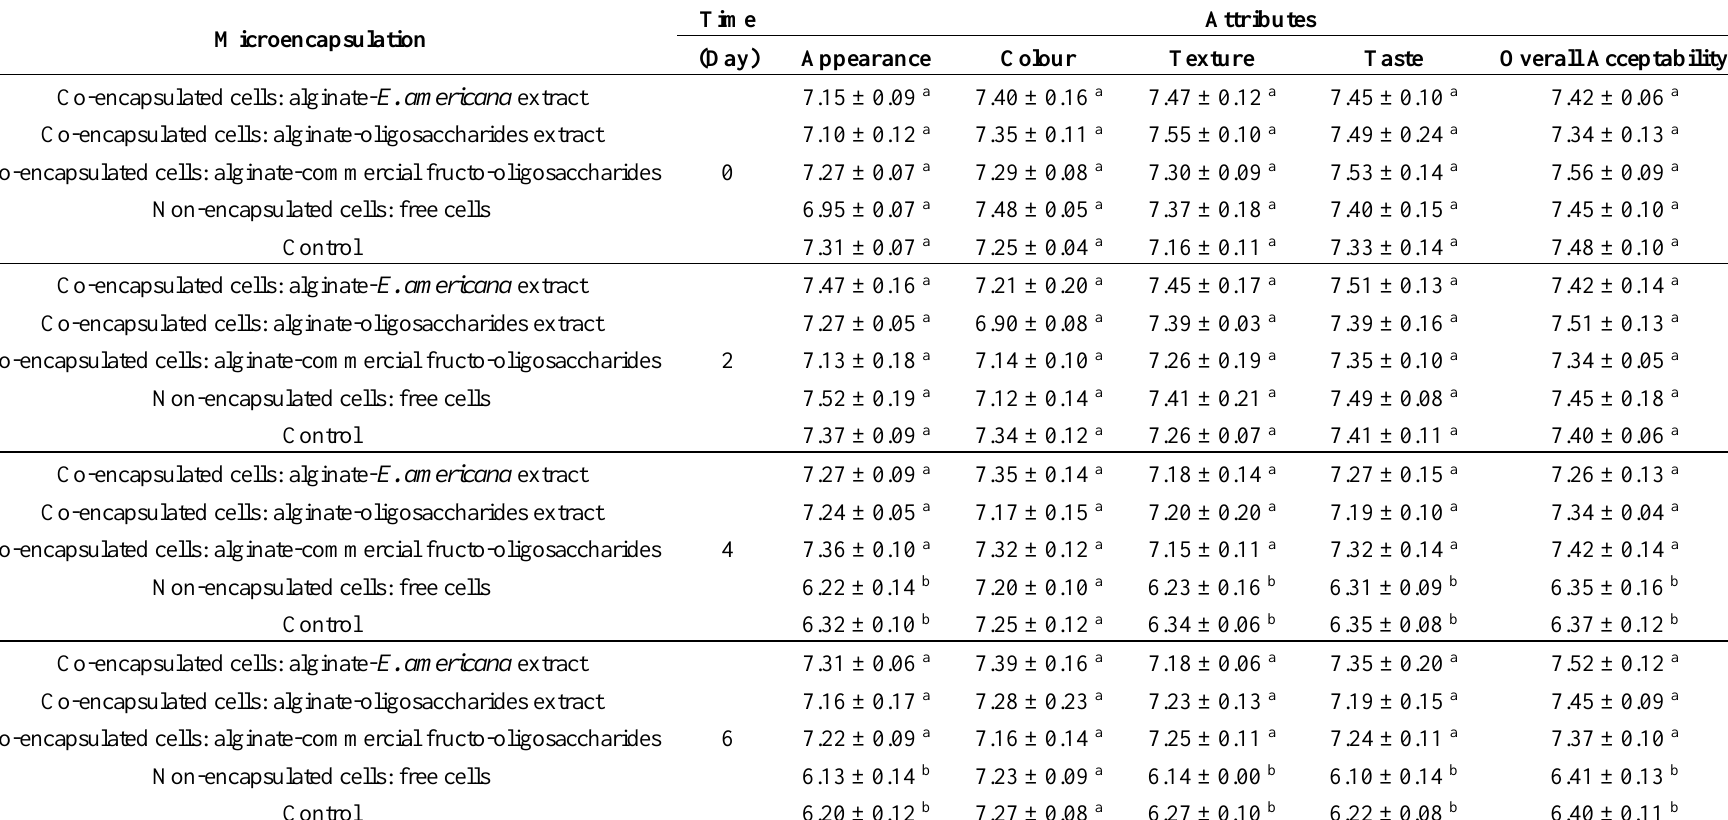
Table 2. Sensory scores of fresh milk tofu supplemented with microencapsulated Bifidobacterium longum with Eleutherine americana during refrigeration